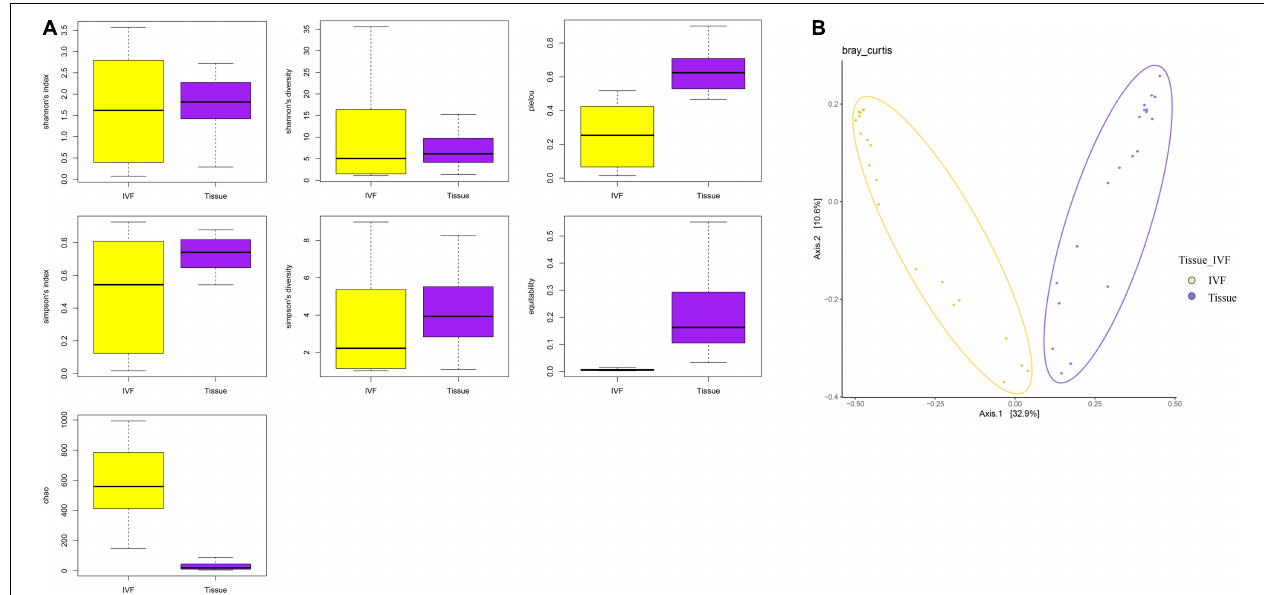
FIGURE 1 | (A) Boxplots represent the indices of observed species. Chao, equitability, Pielou, Shannon’s diversity, and Simpson’s diversity indices in the IVF and tissue groups. IVF, intestinal lavage fluid; tissue, tumor tissue. (B) Beta diversity between the two groups. PCoA analyses. The abscissa is a principal component, the ordinate is another principal component, and the percentage on the coordinate axis indicates the contribution of the two principal components to the sample